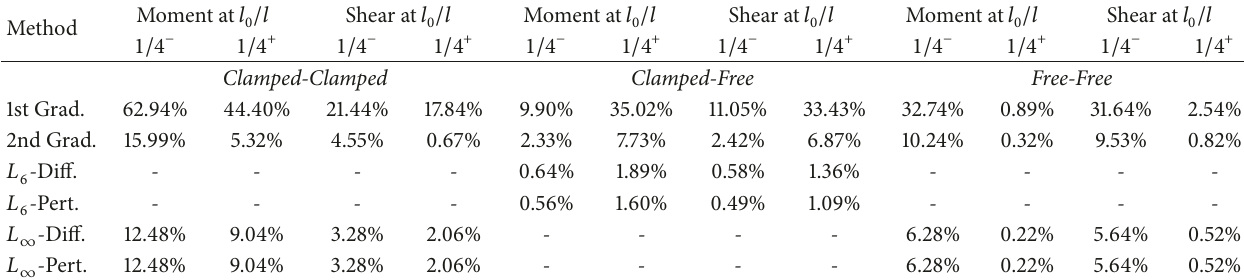
Table 1: Absolute percentage of error in moment and shear prediction of perturbation methods compared to analytical results. Moment at 𝑙 0 /𝑙 Shear at 𝑙 0 /𝑙 Moment at 𝑙 0 /𝑙 Shear at 𝑙 0 /𝑙 Moment at 𝑙 0 Method